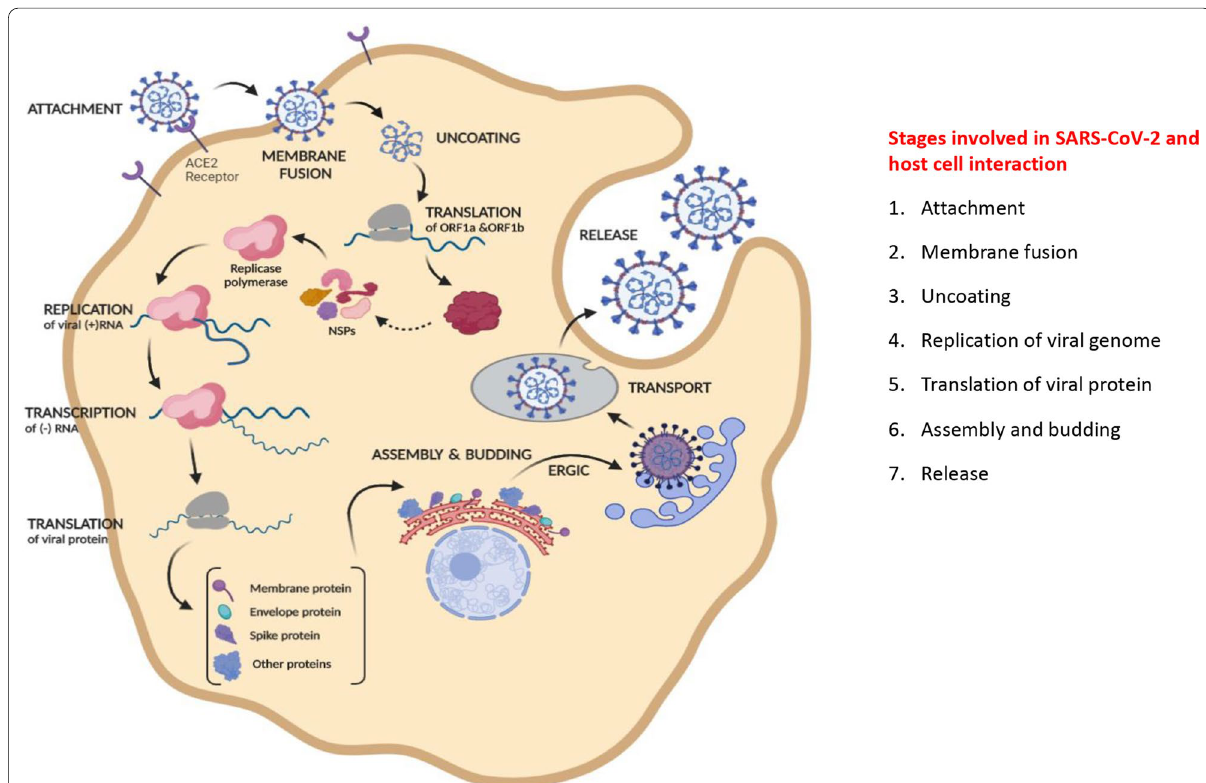
Fig. 2 The interaction and lifecycle of coronavirus. Outline of the intracellular obligate parasitic strategy of SARS-CoV-2 to hijack host